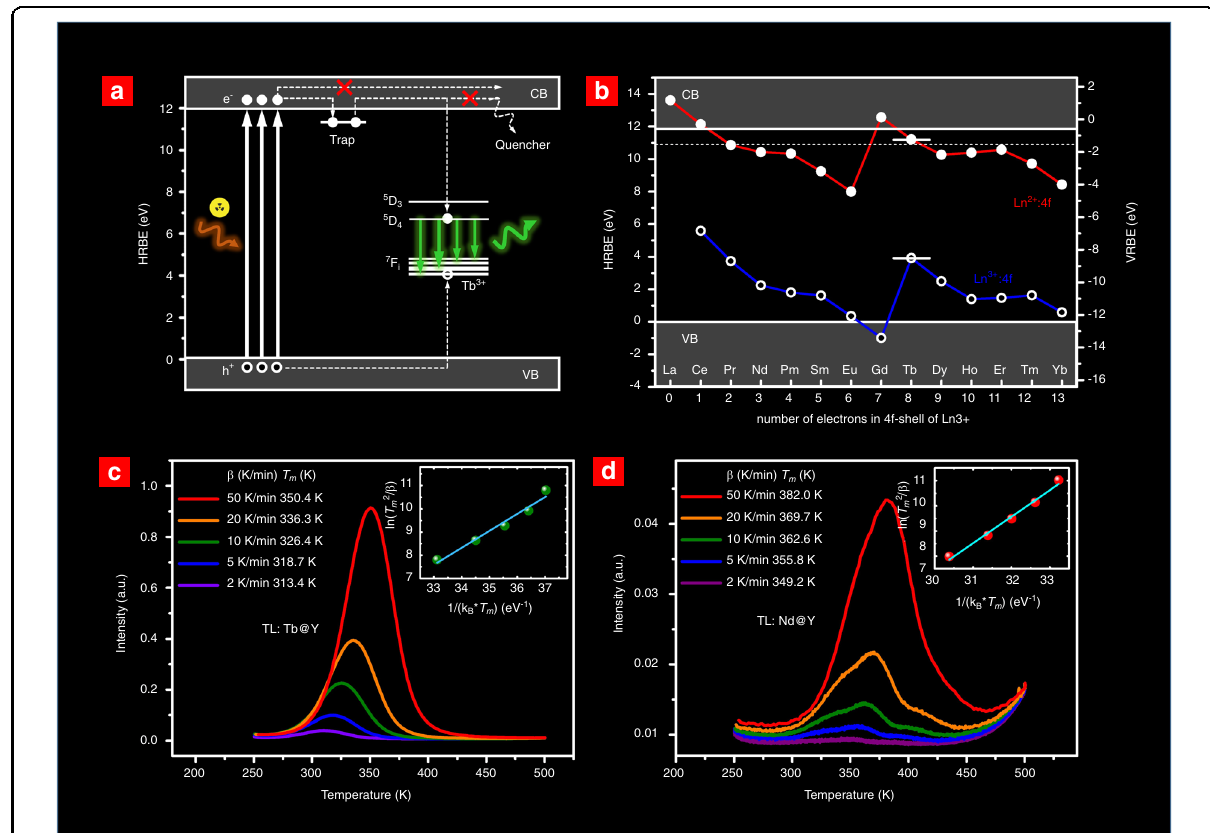
Fig. 2 Mechanism of PersL in the NaYF 4 :Ln 3 + nanoparticles a A proposed energy level diagram to interpret the charge carrier transition process in NaYF 4 :Tb 3 + during and after X-ray irradiation. The energy gap was 11.85eV, and the GS of Tb 3 + was 3.92 eV above the VB top according to the data provided by Dorenbos 62 . The trap depth was estimated to be 0.64 eV according to the TL measurements presented in ( c ). The overall process of PersL includes (i) excitation of electron-hole pairs, (ii) capture by electron traps and Tb3 + , (iii) thermal release of trapped electrons, and (iv) recombination emission of Tb 3 + . Luminescent quenching routes through electron migration are also depicted, which can be blocked by isolating activators from quenchers. b HRBE and VRBE schemes of NaYF 4 . The upper and lower zigzags give the GS of 14 divalent lanthanides (Ln 2 + :4f) and 14 trivalent lanthanides (Ln 3 + :4f). c – d TL glow curves of NaYF 4 :Tb 3 + @NaYF 4 ( c ) and NaYF 4 :Nd 3 + @NaYF 4 ( d ) at different heating rates β from 2 to 50 K/ min. The insets show the corresponding trap depth fi tting using the Hoogenstraaten